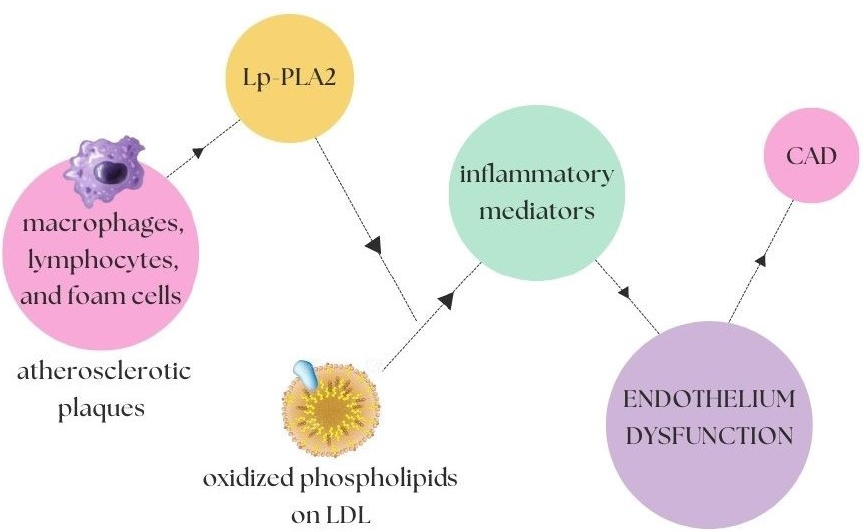
Figure 1. Lp-PLA2-dependent activation cycle [40]. The macrophages, lymphocytes, and foam cells present in the atherosclerotic plaques have an influence on the increased level of Lp-PLA2, which in turn catalyzes a reaction that, in the presence of oxidized phospholipids on LDL, is a direct contribution to the secretion of an increased amount of inflammatory mediators, which in turn leads to endothelial dysfunction and further CAD.